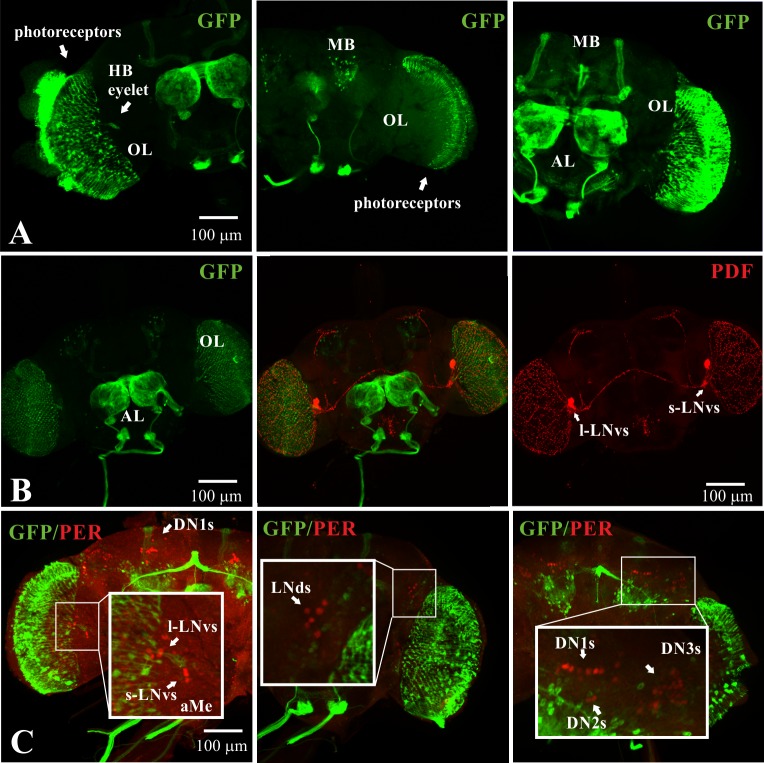
yw(Ti-Gal4)miR-210KO expression in Drosophila brain.yw(Ti-Gal4)miR-210KO flies were crossed with the UAS-cd8-GFP flies. The progeny was collected in between ZT0 and ZT3. Stack of confocal images of (A) miR-210-driven GFP expression in photoreceptors, in the Optic Lobe (OL), Hofbauer-Buchner eyelet (H-B eyelet), Antenna Lobe (AL), and Mushroom Bodies (MB), (B) Double GFP-PDF and (C) GFP-PER staining. (aMe: accessory Medulla). (s-LNvs: small ventral Lateral Neurons; l-LNvs: large ventral Lateral Neurons; 5th-LNvs: 5th ventral Lateral Neuron; LNds: dorsal Lateral Neurons; DN1s: Dorsal Neurons 1; DN2s: Dorsal Neurons 2; DN3s: Dorsal Neurons 3).